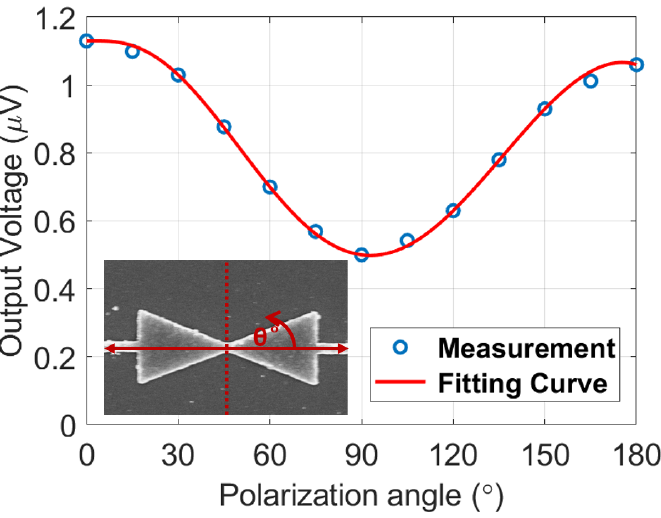
Figure 7. Polarization-dependent output voltage (V oc ) from the device with the linear I-V